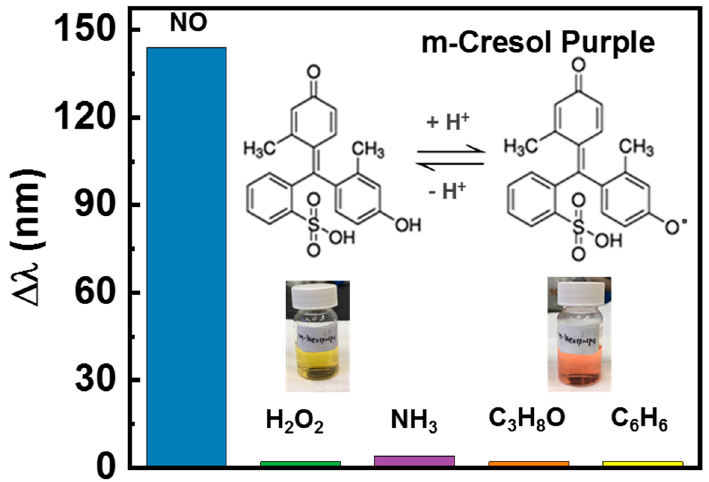
Figure 5. Selectivity analysis of m ‐ Cresol Purple dye towards NO and other analytes.